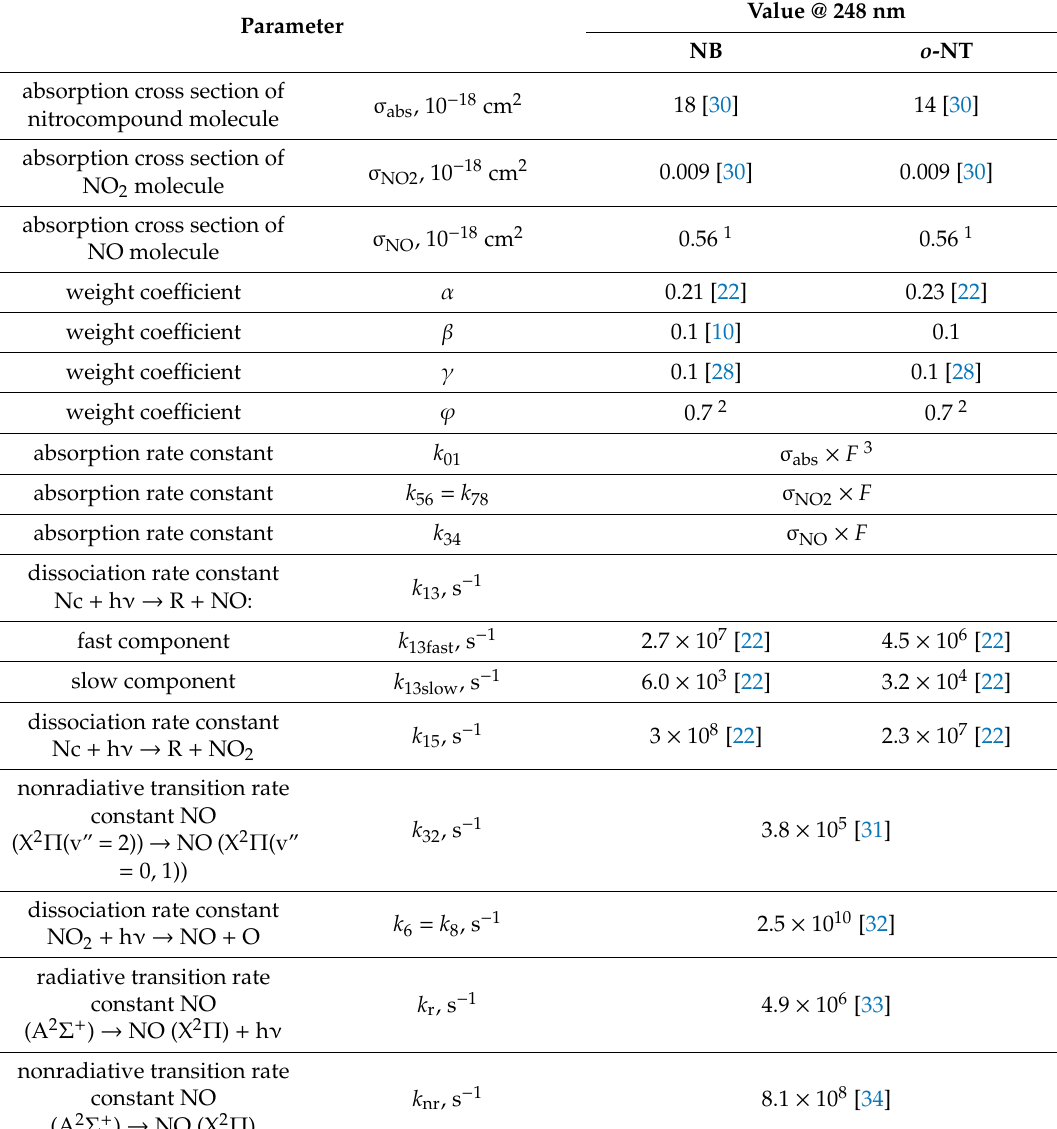
Table 1. Input parameters of the kinetic